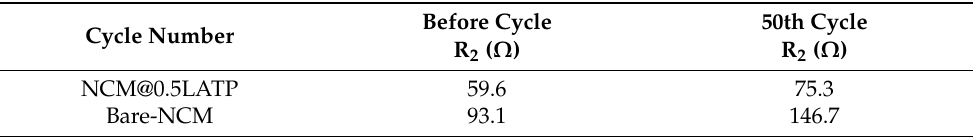
Figure 8. EIS results of ( a ) bare NCM and ( b ) NCM@0.5LATP; inset is the used equivalent circuit model. Table 1. Fitted impedance parameters.